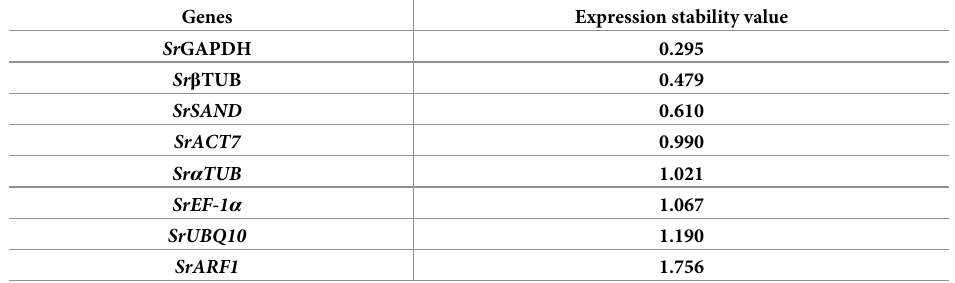
Table 4. Candidate reference genes and best combination of two genes listed according to their expression stabil- ity calculated by NormFinder in transiently transformed